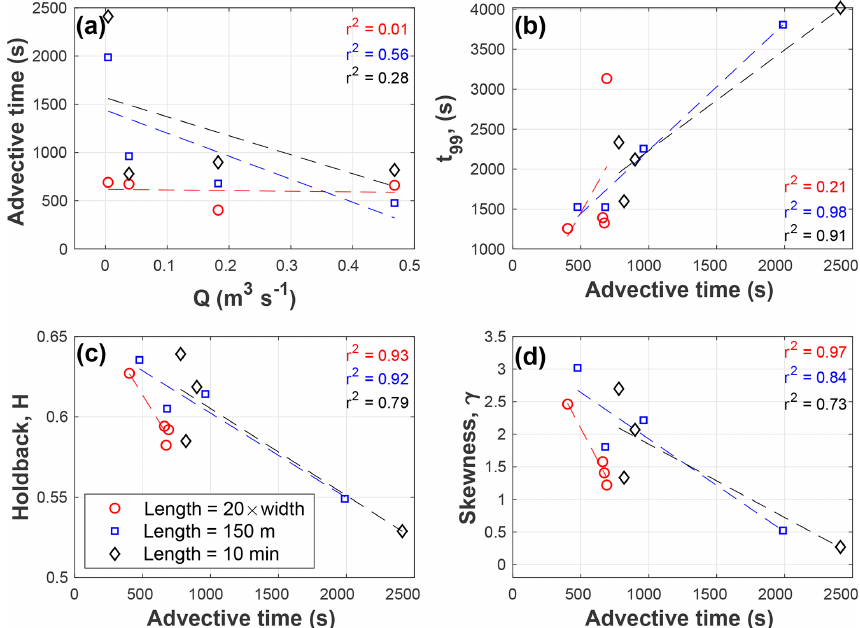
Figure 5. Comparison of fixed-reach (150m), adaptive-reach length (20 wetted channel widths), and fixed-advective-time (10min) ap- proaches for standardization of stream solute tracer studies. (a) Control of advective time across 4 stream orders. Additional panels show the observations and a best-fit linear regression for (b) longest detection timescale, (c) holdback, and (d) skewness in relation to the advective time of the study. Best-fit linear regressions are shown as dashed lines in each